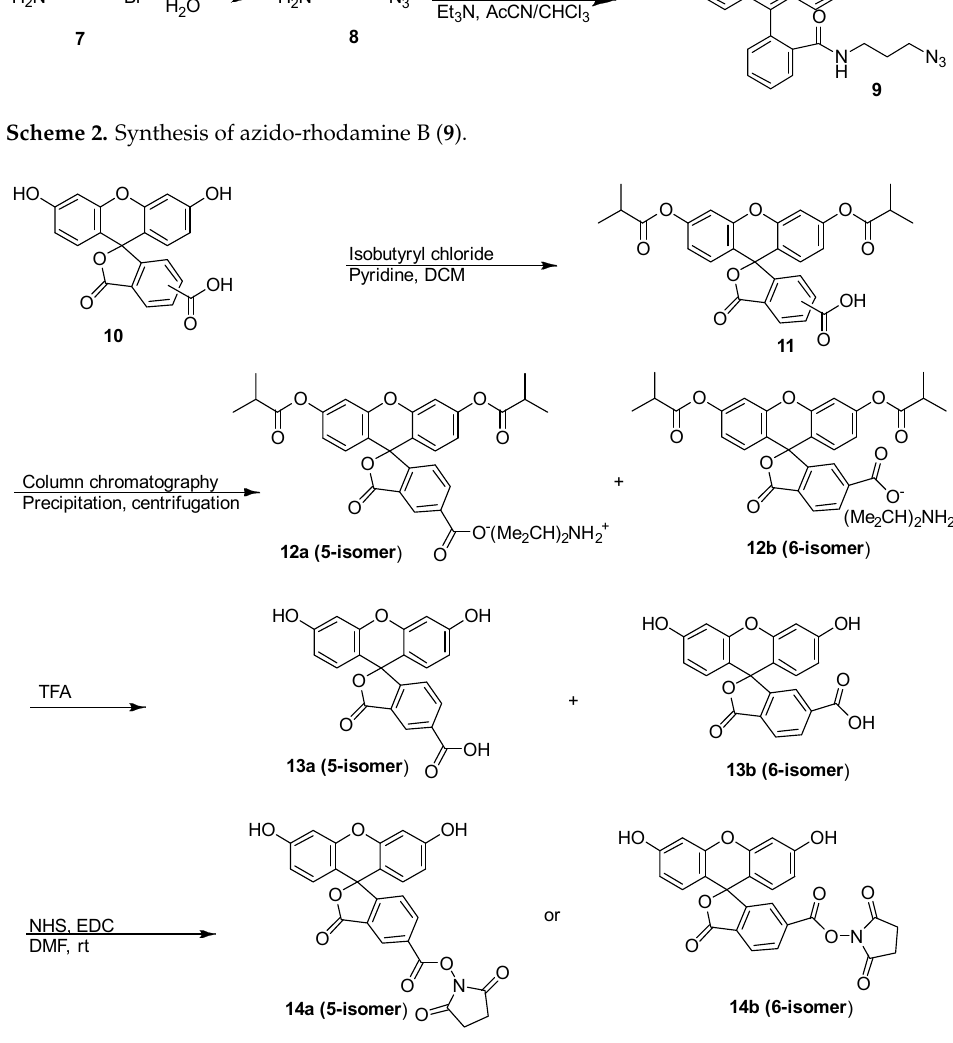
Scheme 3. Reaction sequence for separating 5(6)-carboxyfluorescein (FAM) into geometric isomer- pure 5-carboxyfluorescein (5-FAM, 13a ) and 6-FAM ( 13b ), which were further derivatized to provide the corresponding NHS esters 14a and 14b,